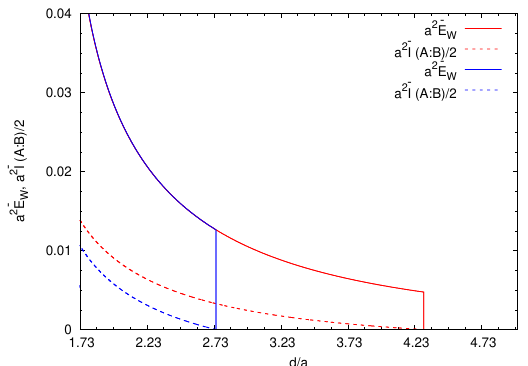
Figure 6 . Effect of UV/IR mixing on EWCS and HMI. In the above plot, the red curves (both solid and dotted) correspond to au b = 10 and the blue curves (both solid and dotted) correspond to au b = 20 . We have set l = 6 a